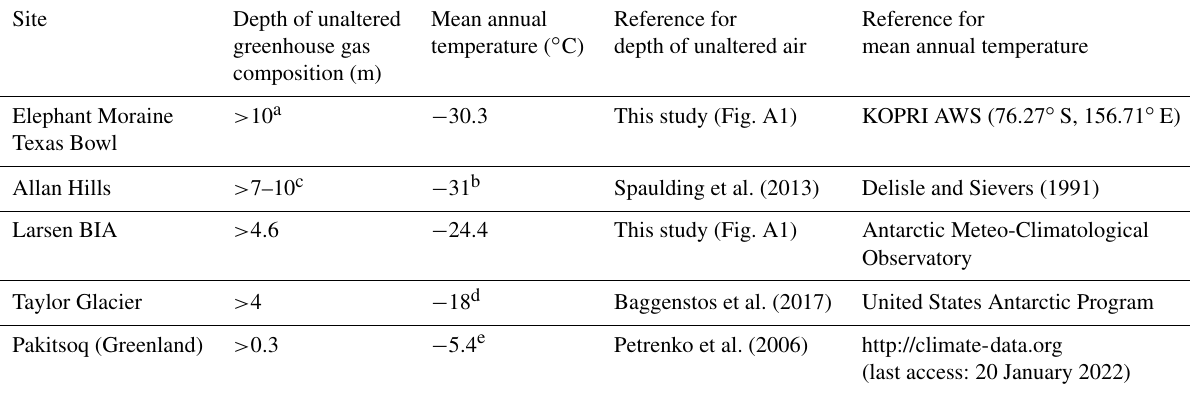
Table 1. Depth of unaltered greenhouse gas compositions and mean annual temperature of BIAs. Site Depth of